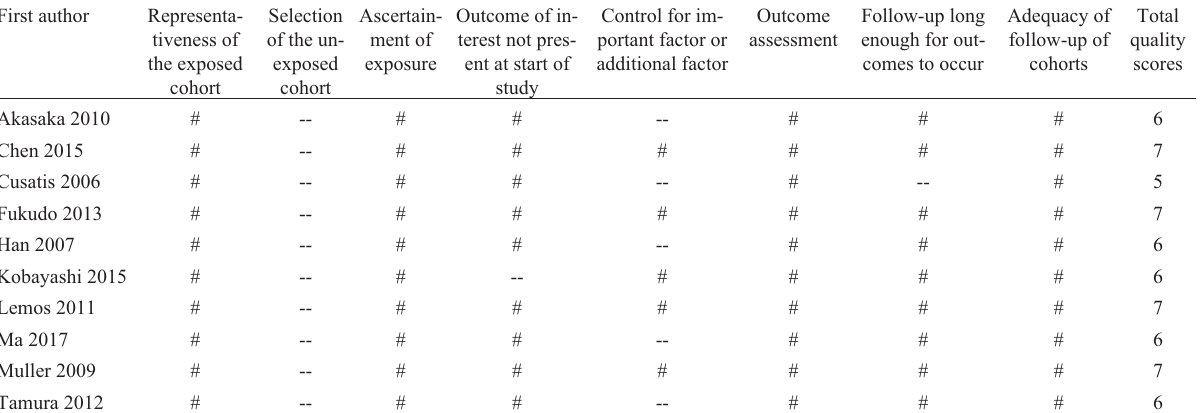
Table 2 - Quality assessment of the included studies with Newcastle-Ottawa quality assessment scale. First author